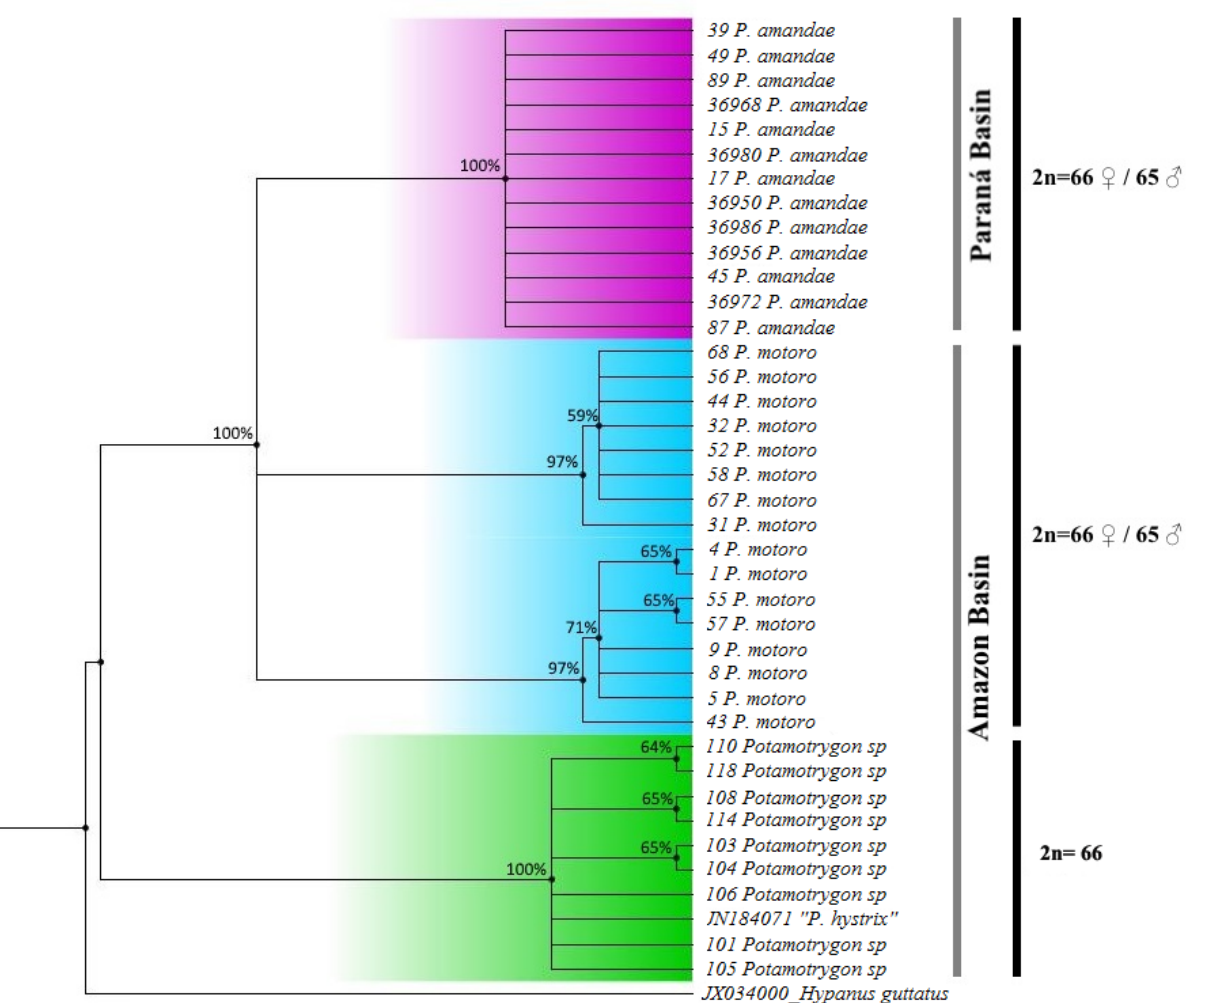
Figure 3 – Neighbor-Joining tree of the COI gene sequence and the sex chromosome systems found in potamotrygonins species, including Potamotrygon amandae from the Paraná basin (purple), P. motoro (blue) and Potamotrygon sp. from the Amazon basin, and P. histrix (JN184071 “P. hystrix” ) (green). The bootstrap values are shown at the branch